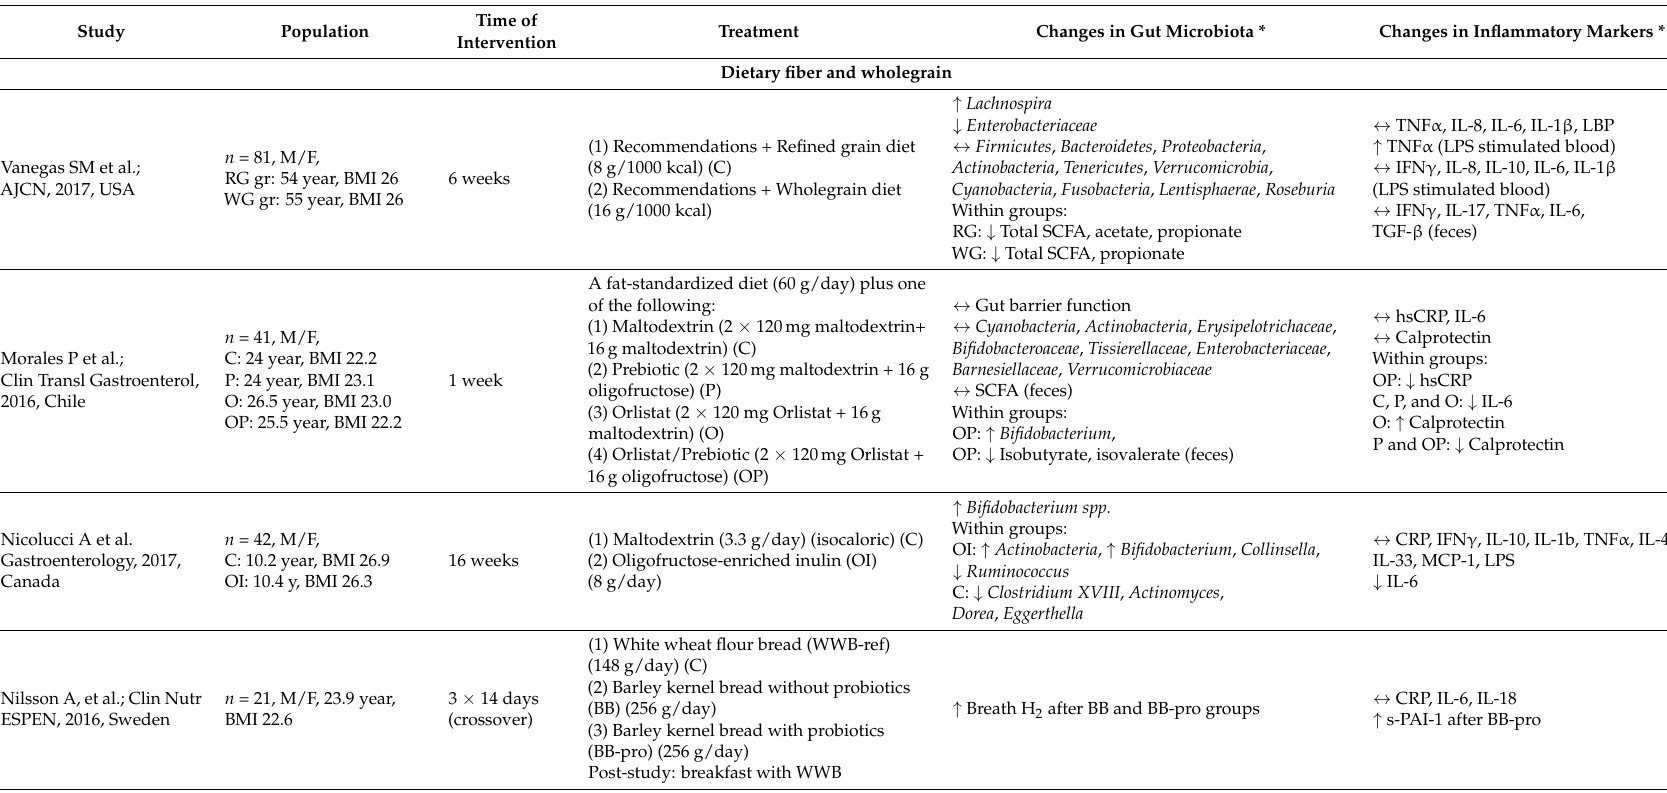
Table 2. Dietary intervention studies evaluating changes in gut microbiota composition and inflammatory markers in healthy lean and overweight/obese children and adults. Time of Study Population Treatment Changes in Gut Microbiota * Changes in Inflammatory Markers * Intervention Dietary fiber and